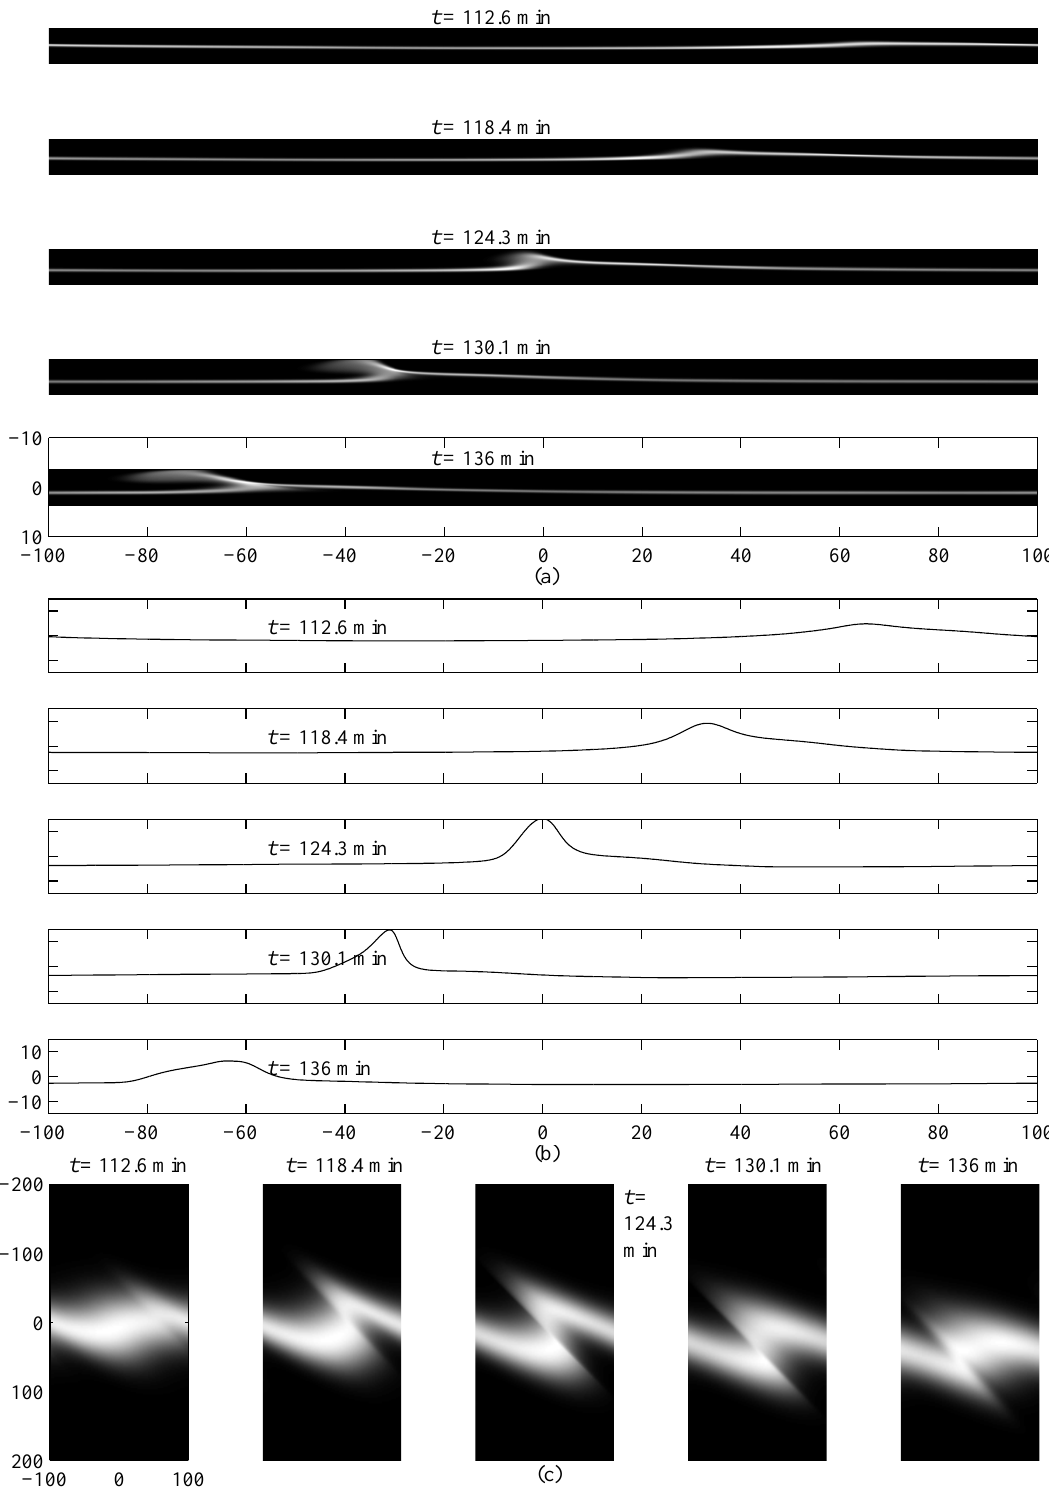
Figure 2: Seed wavelength of 200 km with Σ H Σ = 1 . 8. (a) E s layer, (b) electric field, and (c) F layer. The axes for all = 1 . 8. (a) E s layer, (b) electric field, and (c) F layer. The axes for all figures are described in Fig. 2. Seed wavelength of 200km with 6 H PF 6 PF figures are described in Section 2.2, and summarized in Figure 1. Sect. 2.2, and summarized in Fig.